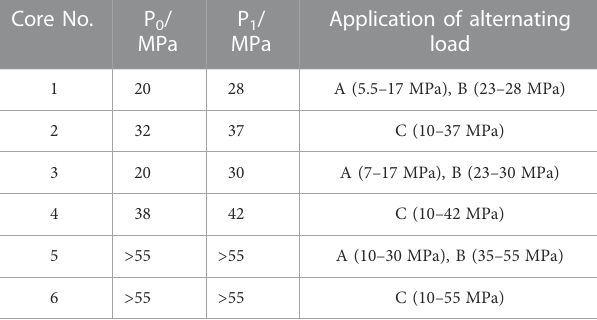
TABLE 3 Simulation test conditions of core sand